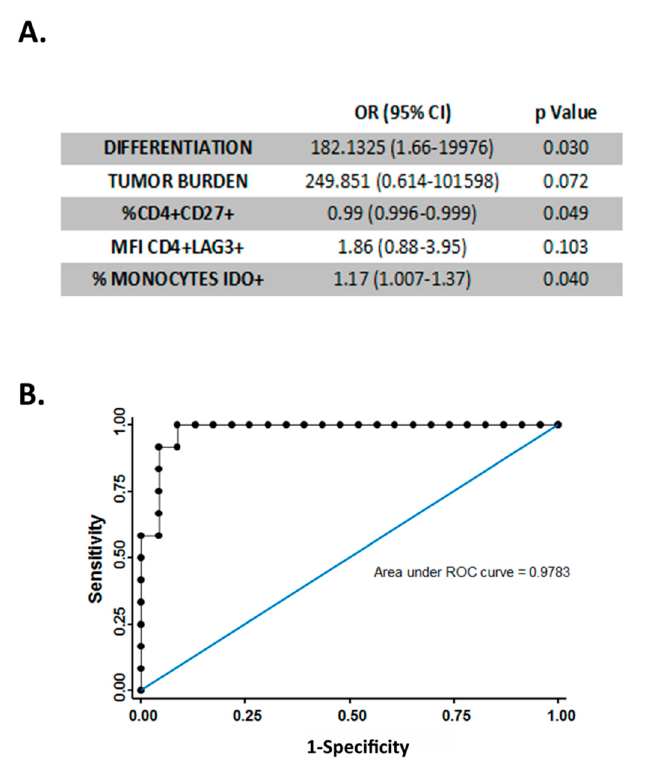
Figure 4. Multivariable analysis. ( A ) Table showing multivariable logistic regression to compare individuals with pTa and individuals with pT1 tumors. All covariates with a p -value < 0.1 in the univariable analysis were considered. ( B ) ROC curve showing the ability of the parameters shown in A. to discriminate between patients bearing pTa and pT1 tumors. Sensitivity 75.00%, specificity 95.65%, positive predictive value, 90.00%, and negative predictive value, 88.00% .